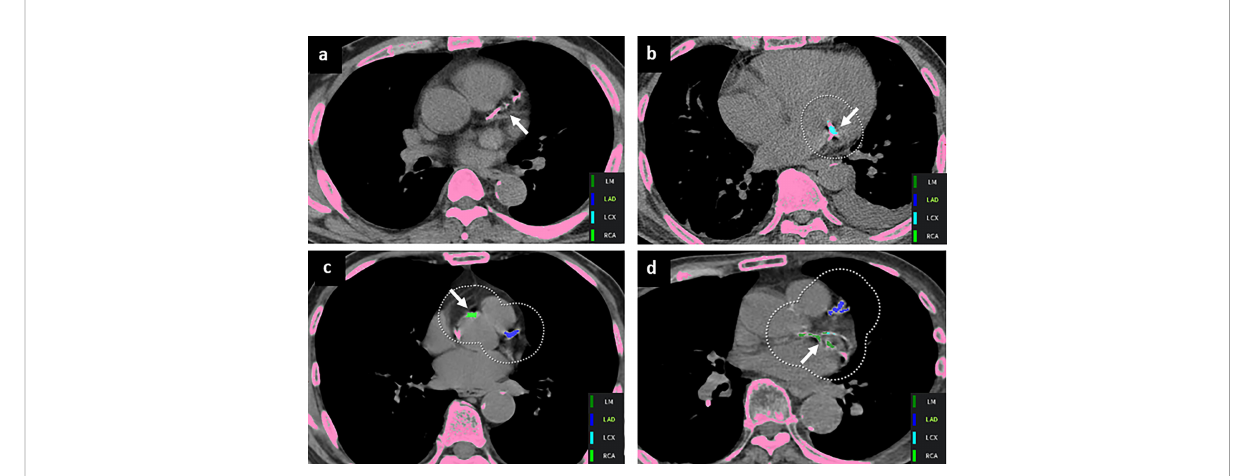
FIGURE 3 Representative mismatched coronary artery calcium lesions. (A) A false-negative fi nding was noted in the left anterior descending artery (arrow). False-positive lesions were annotated with arrows in the (B) mitral annulus and (C) aorta wall. (D) CAC on the left circum fl ex artery was mislabeled as the left main artery